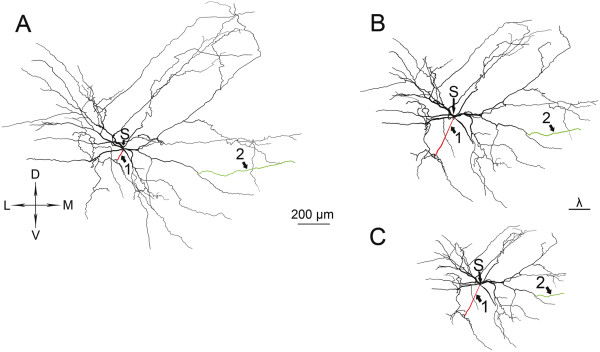
Dendritic morphology and morphoelectrotonic transforms of a cervical motoneuron. Morphology (A) and METs (B) and (C) of the same MN (C-167) with homogeneous (Rms = Rmd) and inhomogeneous (Rms < Rmd) soma-dendrite membranes constrained by the physiological 5 MΩ somatic input resistance of the MN for both METs. Arrows 1 and 2 point to homologous proximal (red) and distal (green) dendritic branches where changes during METs are visibly non-proportional to their geometrical sizes (for quantitative analysis see body text). Arrows labeled by S point to the center of the soma (its entire shape is not shown in the figures). D-dorsal, V-ventral, M-medial, L-lateral directions. Note the different size of the MET with our choice of the physiologically constrained pair of Rms-Rmd values in the inhomogeneous soma-dendritic membrane (C) relative to the MET of the same MN with homogeneous membrane (B) drawn to a common scale of space constants. Both METs show attenuations of somatopetal PSP propagation (‘Vin mode’ in NEURON) at DC input (frequency = 0 Hz), recording electrode was at mid-soma, stimulating electrode was at mid-points of dendritic compartments. Dendritic and somatic specific membrane resistances (Rmd and Rms) were equally 8348 Ωcm2 for the homogeneous soma-dendritic membrane, while for the MET with inhomogeneous membrane Rmd and Rms were 20000 and 1046 Ωcm2 respectively. With these Rms and Rmd values the somatic input resistance was 5 MΩ in both membrane models of the MN.